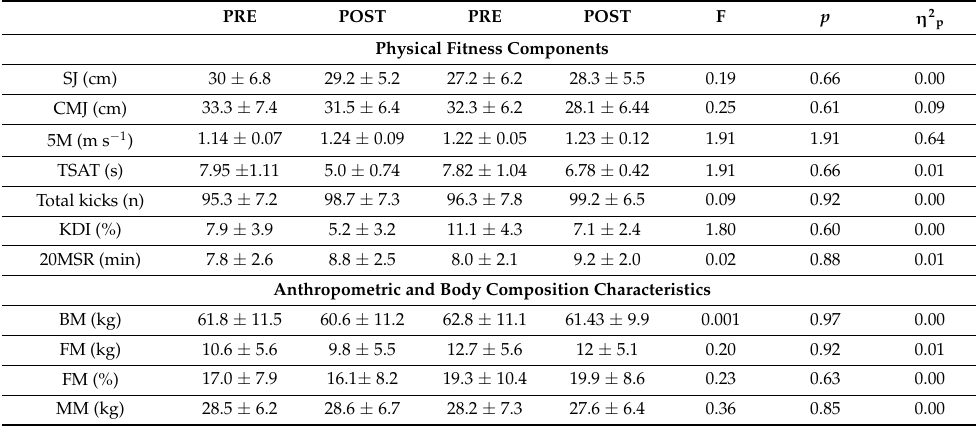
Table 2. Pre- and post-intervention differences between HIIT vs. traditional training protocols on physical fitness and body composition in taekwondo athletes ( n =